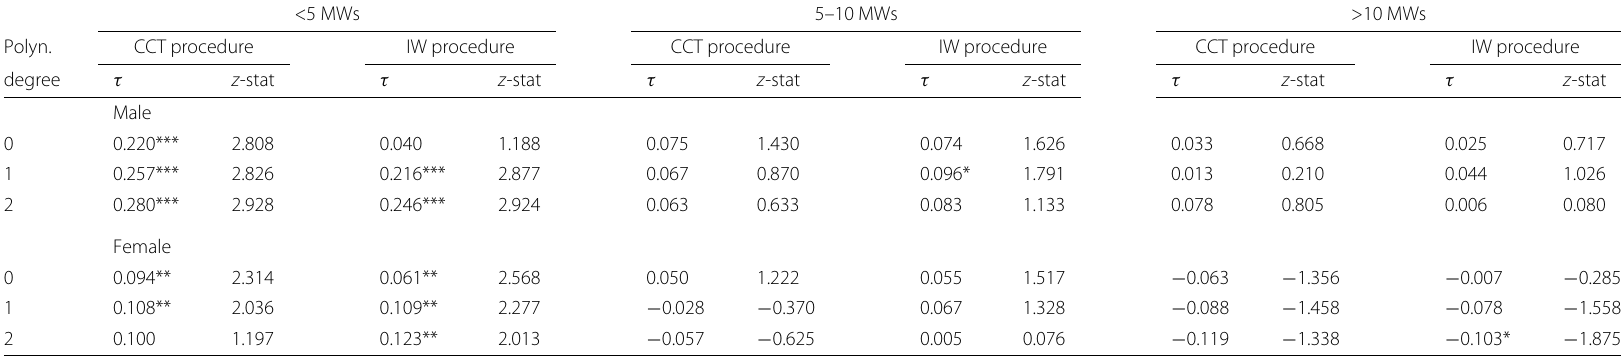
Table 6 RD estimates of test scores by household